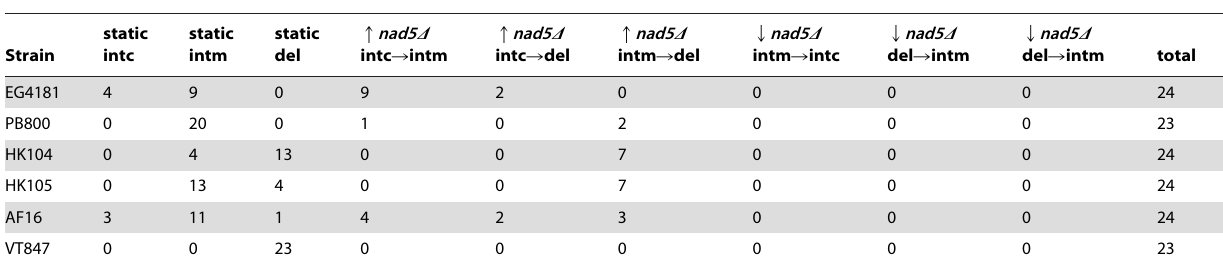
Table 1. Changes in nad5 D PCR band genotype from G0 to G10.